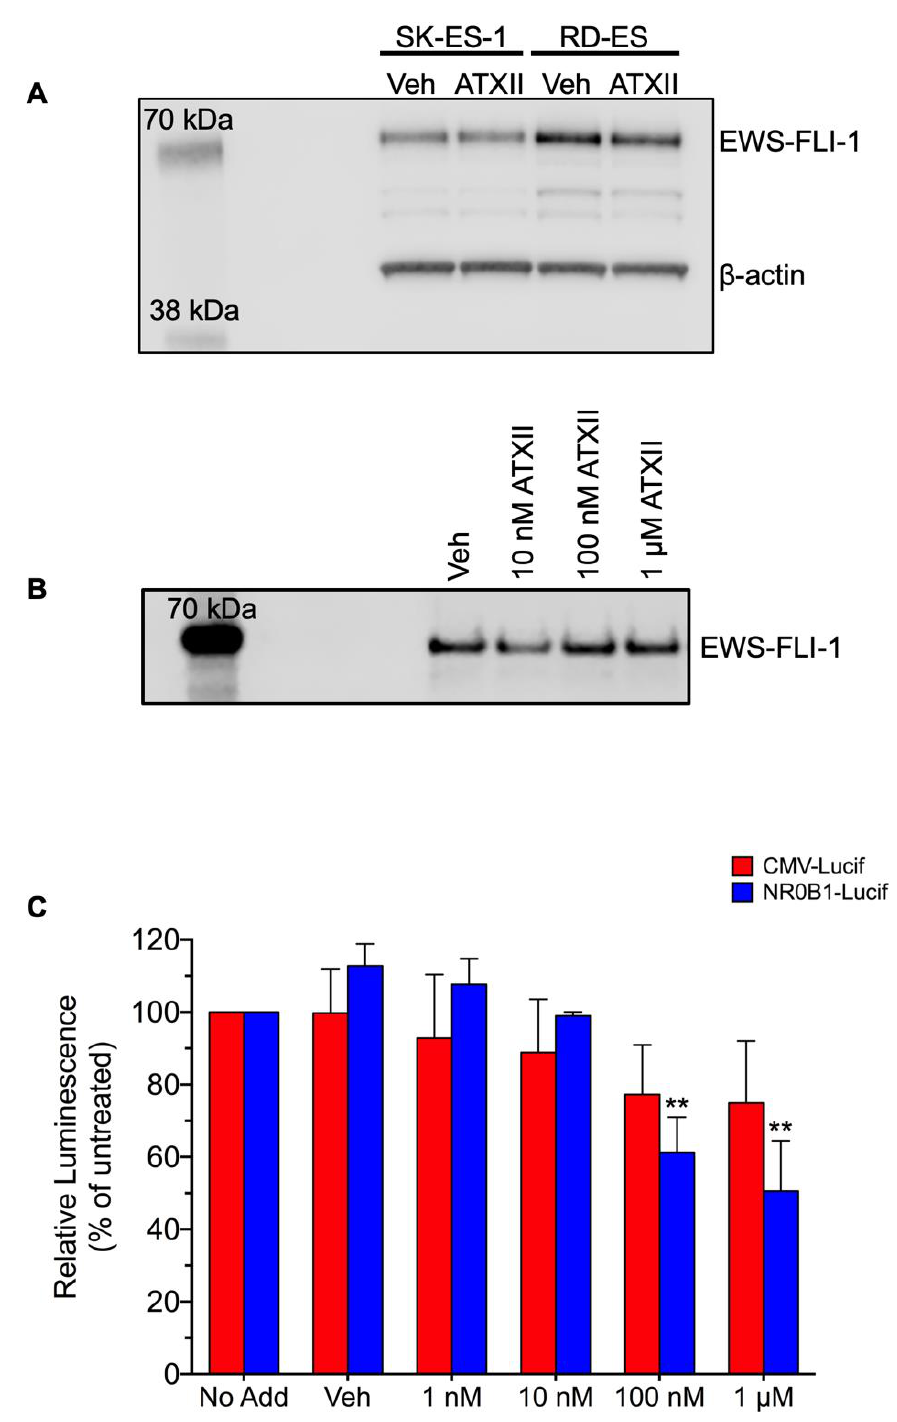
Figure 4. Effects of ATXII on EWS-FLI1 protein levels and transcriptional activity. ( A ) Immunoblot- ting for EWS-FLI1 (anti-FLI1) and β -actin in SK-ES-1 and RD-ES lysates following treatment with 100 nM ATXII for 8 h. ( B ) Immunoblotting for EWS-FLI1 (anti-FLI1) in A-673 lysates following treatment with a range of concentrations for 24 h. ( C ) Effects of ATXII on the promoter activity of the EWS-FLI1 target gene NR0B1. The cells were treated for 6 h with the indicated concentration of ATXII, and the activity was measured by a luciferase reporter assay. n = 3 independent experiments, with all concentrations tested in triplicate. ** p ≤ 0.01 compared to vehicle; one-way ANOVA with Tukey’s post -hoc test.